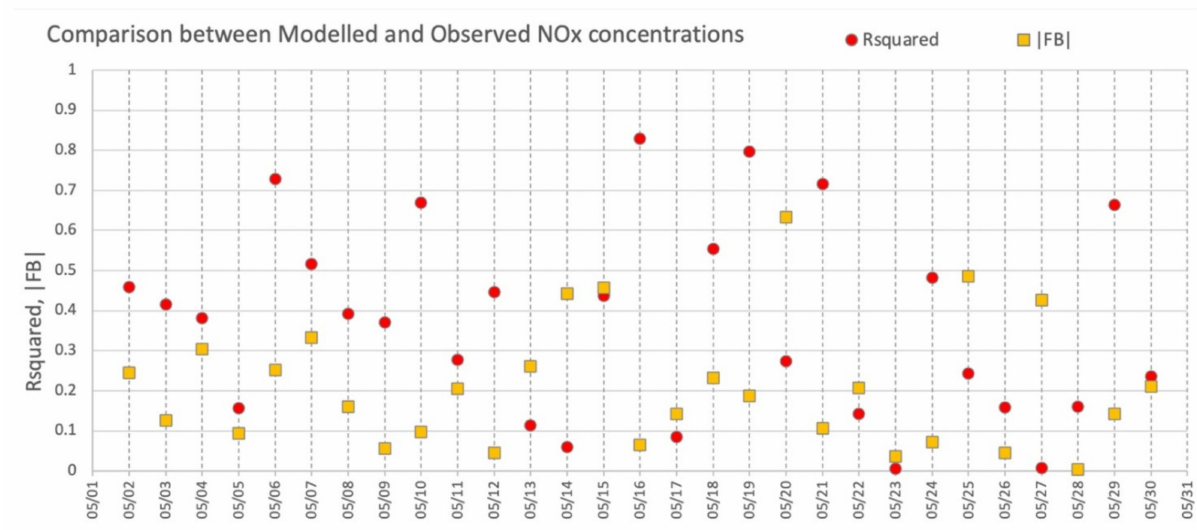
Figure 9. Daily linear correlation coefficients and the absolute value of the daily fractional bias relative to the time series shown in Figure